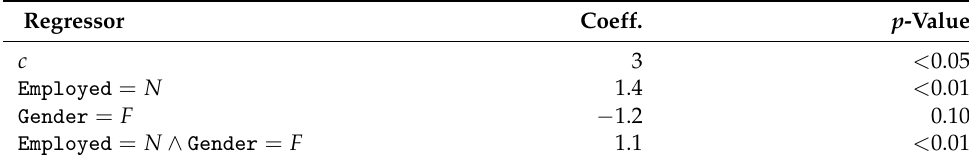
Table A1. Example of regression